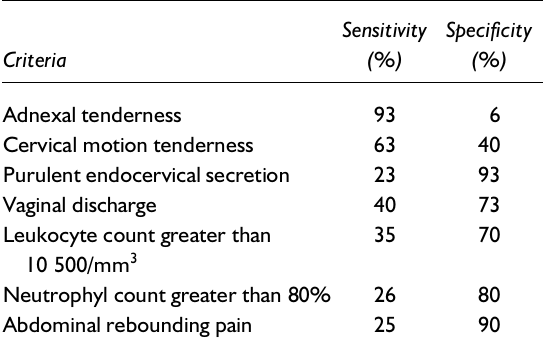
Table 3 Diagnostic operative characteristics of clinical and laboratory criteria for pelvic inflammatory disease in 61 patients having non-specific lower abdominal pain